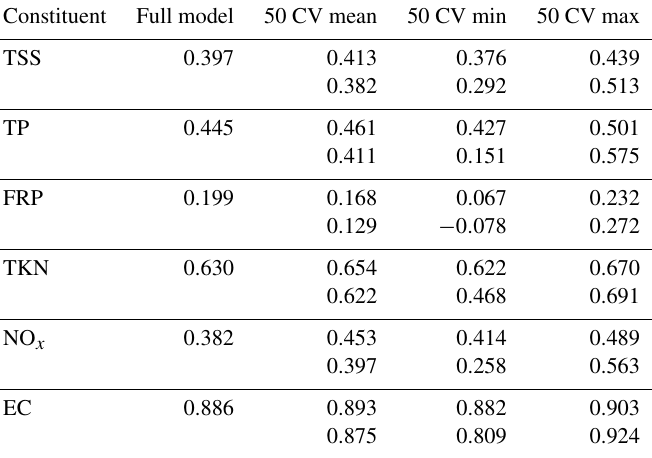
Table 5. Comparison of the model performance (NSE values) of the full model (column 2) and the 50 partial models (columns 3–5) that were each calibrated using 80% of the monitoring sites, which were randomly selected. Columns 3 to 5 summarize the mean, minimum and maximum NSE values across the 50 runs of cross-validation (CV), where the top row shows the calibration performance and the bottom row shows the validation performance (i.e., at the 20% sites that were not used for calibration) for each